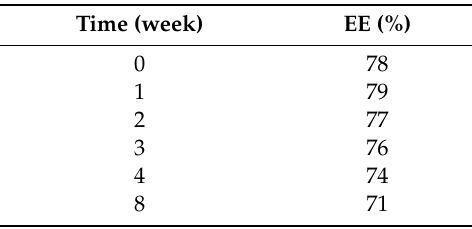
Table 5. Stability of the formulation F-5.